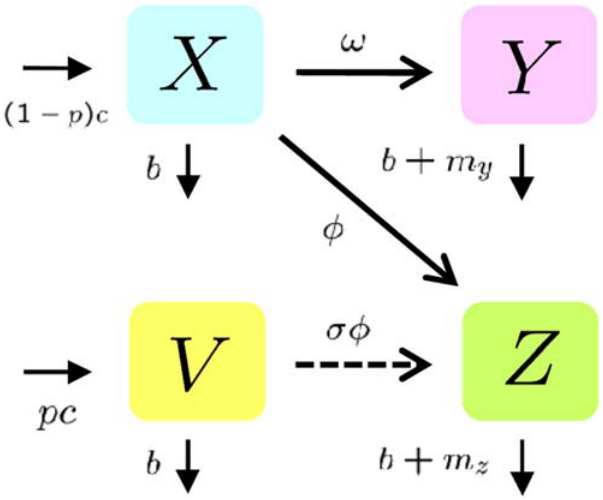
Figure 1. Model structure for the emergence of vaccine- resistant strain during a vaccination program: Susceptible birds ( X ) become infected with vaccine-sensitive ( Y ) and vaccine-resistant ( Z ) strains at rates in direct relation to the number of respective infectious birds. We assume that vaccinated birds ( V ) can be protected completely from the vaccine-sensitive strain, but are partially protected from vaccine-resistant strains with a loss of protection effectiveness of the vaccination ( s ). See the Mathematical model section for corresponding equations.